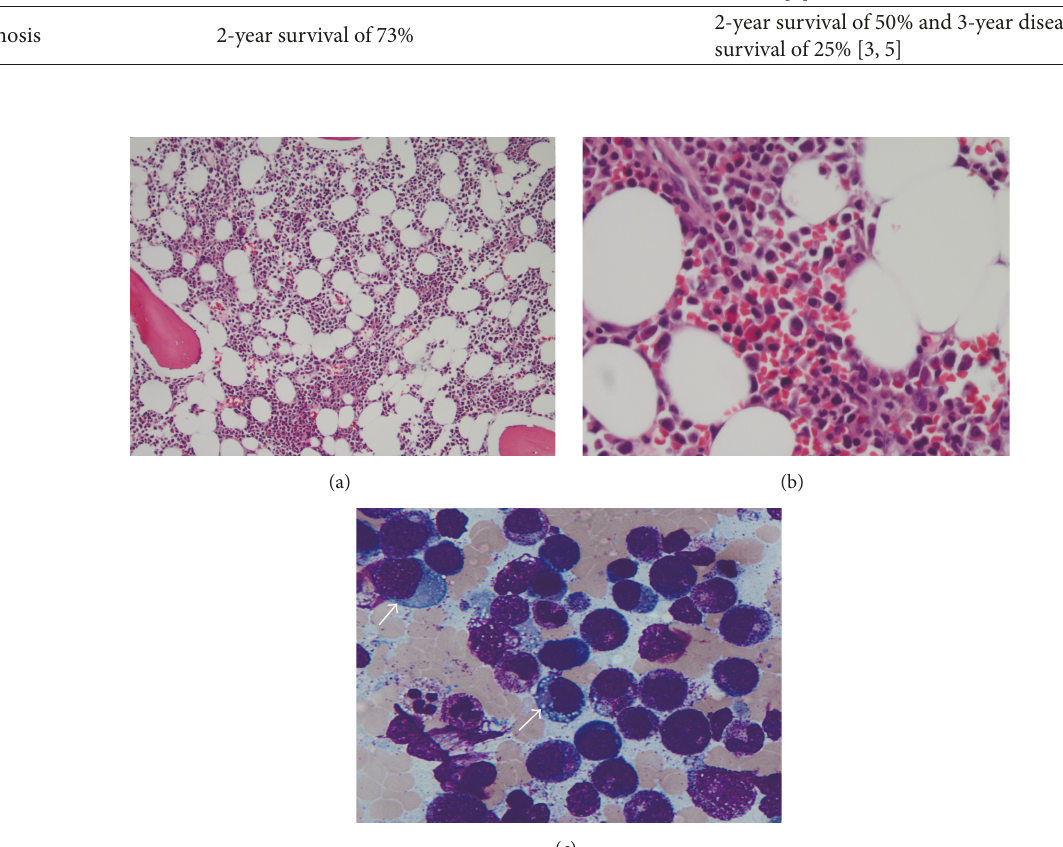
Figure 4: Morphological features of bone marrow core biopsy and aspiration. The H&E section of bone marrow core biopsy demonstrated hypercellularity for the patient’s age with myeloid hyperplasia ((a) 100x magnification; (b) 400x magnification). Scattered lymphoma cells (pointed by the white arrows) were easily seen on aspirate smears ((c) Wright’s stain, 1000x magnification) but not easily discernible on H&E